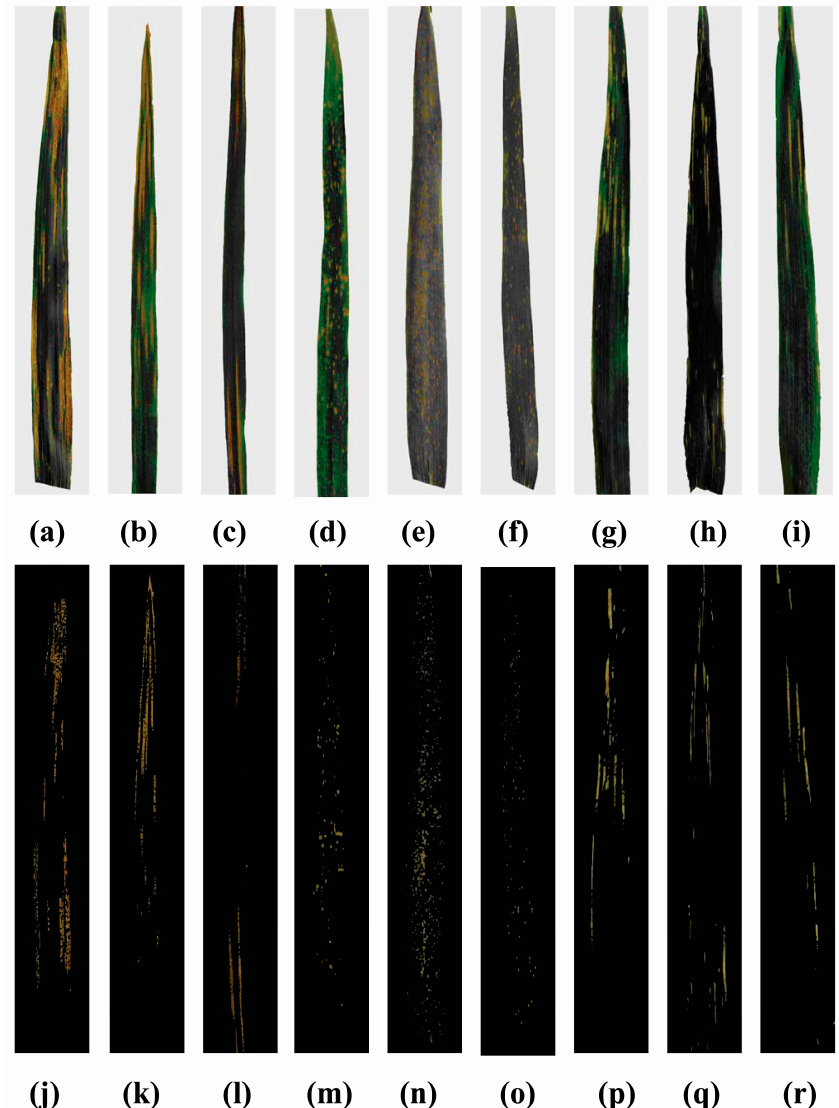
Figure 2. The original single-diseased-leaf images and the corresponding segmented color lesion images of wheat stripe rust and wheat leaf rust on different varieties, acquired in the wheat fields in Shangzhuang Experimental Station and Gangu Testing Station. To ensure a clear demonstration, all the images are shown after being uniformly cropped. ( a – c ) are the original single-diseased-leaf images of wheat stripe rust on wheat varieties Beijing 0045, Mingxian 169, and Nongda 211, acquired in the wheat field in Shangzhuang Experimental Station, respectively; ( d – f ) are the original single-diseased-leaf images of wheat leaf rust on wheat varieties Beijing 0045, Mingxian 169, and Nongda 211, acquired in the wheat field in Shangzhuang Experimental Station, respectively; ( g – i ) are the original single-diseased-leaf images of wheat stripe rust on wheat varieties Longjian 9822, Longjian 9825, and Tianxuan 66, acquired in the wheat field in Gangu Testing Station, respectively; ( j – l ) are the segmented color lesion images of the single-diseased-leaf images of wheat stripe rust on wheat varieties Beijing 0045, Mingxian 169, and Nongda 211, acquired in the wheat field in Shangzhuang Experimental Station, respectively; ( m – o ) are the segmented color lesion images of the single-diseased-leaf images of wheat leaf rust on wheat varieties Beijing 0045, Mingxian 169, and Nongda 211, acquired in the wheat field in Shangzhuang Experimental Station, respectively; and ( p – r ) are the segmented color lesion images of the single-diseased-leaf images of wheat stripe rust on wheat varieties Longjian 9822, Longjian 9825, and Tianxuan 66, acquired in the wheat field in Gangu Testing Station, respectively.